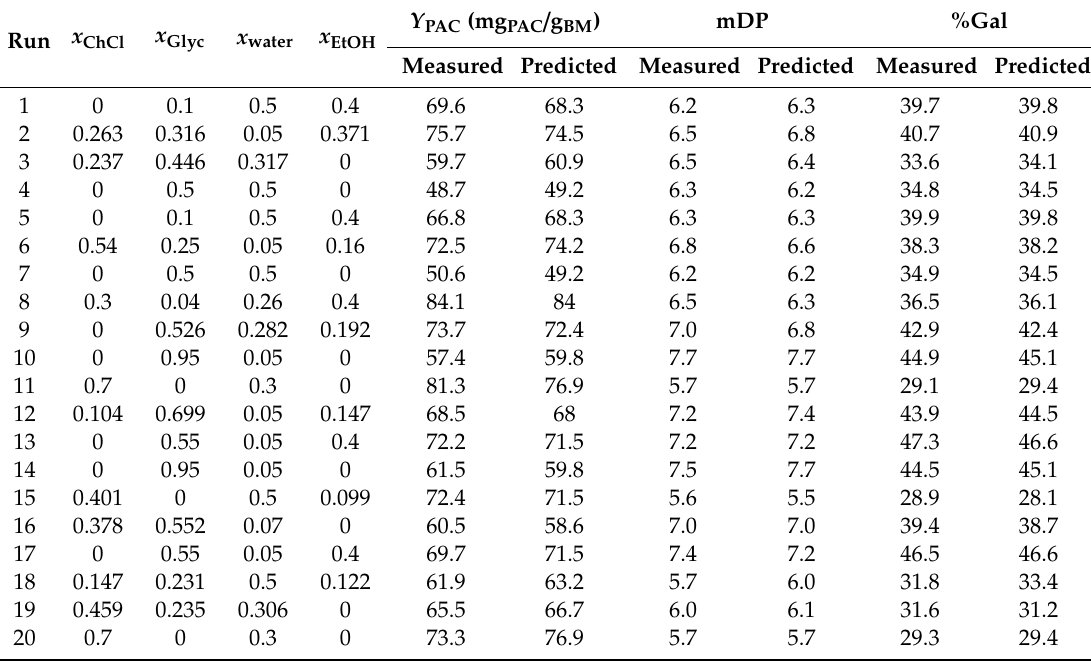
Table A1. Mass fractions of choline chloride, glycerol, water and ethanol used in optimization of solvent composition and respective measured and predicted values of Y PAC , mDP and